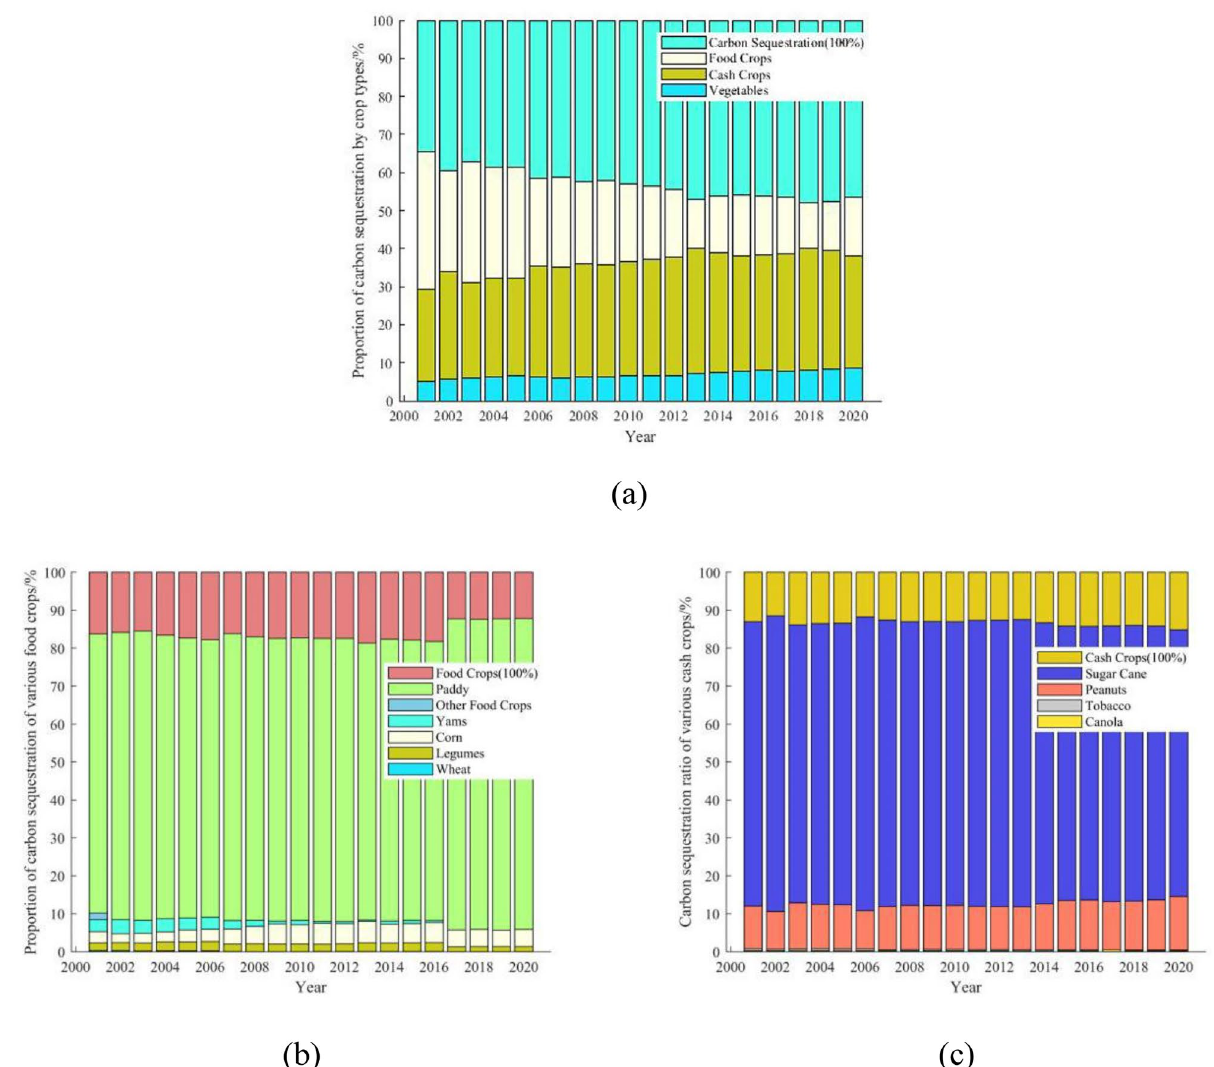
Figure 4. ( a ) Proportion of carbon sequestered by various crops in Guangdong farmland ecosystems. ( b ) Proportion of carbon sequestered by various food crops in Guangdong farmland ecosystems; ( c ) proportion of carbon sequestered by various cash crops in Guangdong farmland